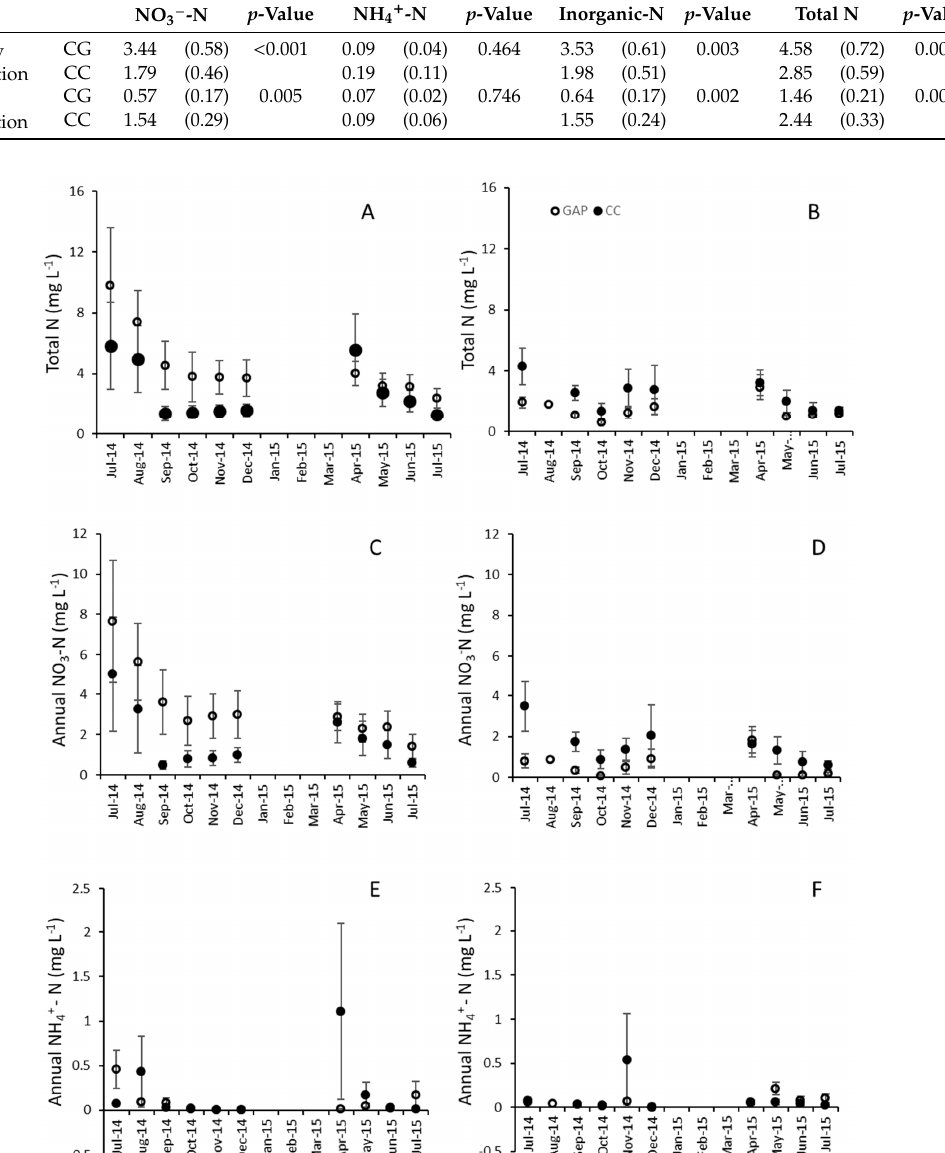
Figure 5. Mean (± SD) total N (A,B) NO 3 ‐ ‐ N (C,D), and NH 4+ ‐ N (E,F) concentrations (mg L − 1 ) in the soil 16 solution at 30 cm depth. The Closed Canopy (CC) sites (closed circles) and the Canopy Gap (CG) sites 17 (open circles) for the new (left ‐ hand plots) and old (right ‐ hand plots) infestations shown in the time series 18 throughout the collection year. 19 sites (open circles) for the new (left-hand plots) and old (right-hand plots) infestations shown in the time series throughout the collection